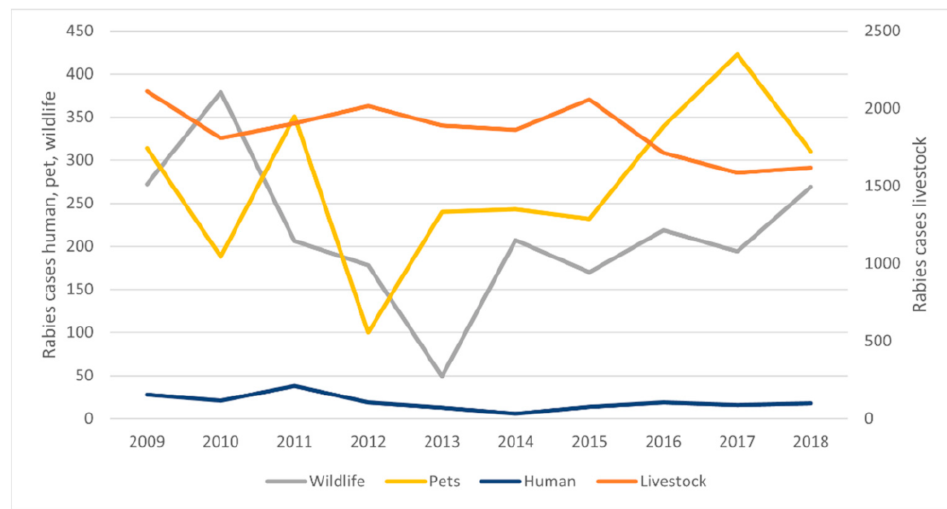
Figure 1. Trends for rabies cases in different animal categories during the period 2009–2018 in South American countries. (Source OIE-WAHIS and